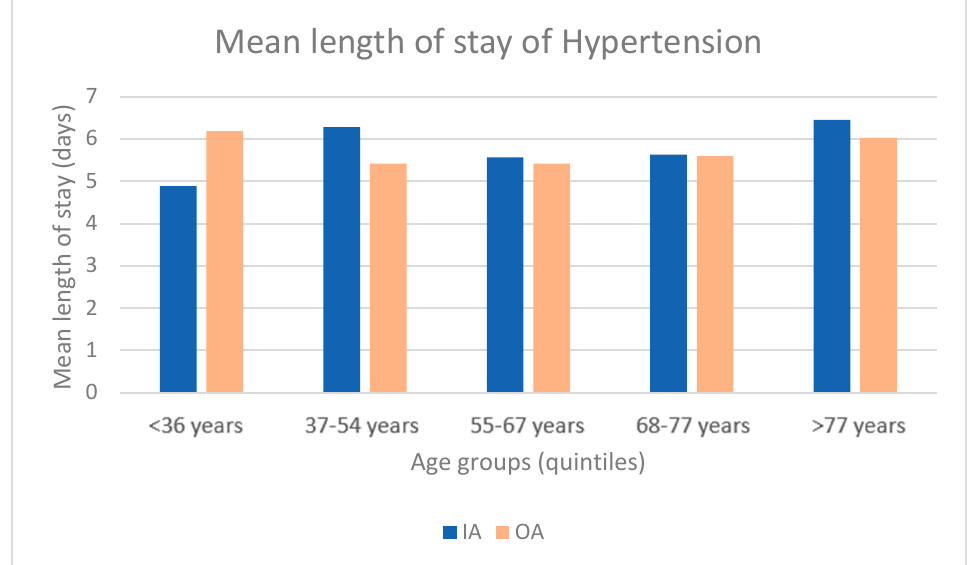
Figure 5. Comparison of the mean length of stay of hypertension and OA (2018–2021).